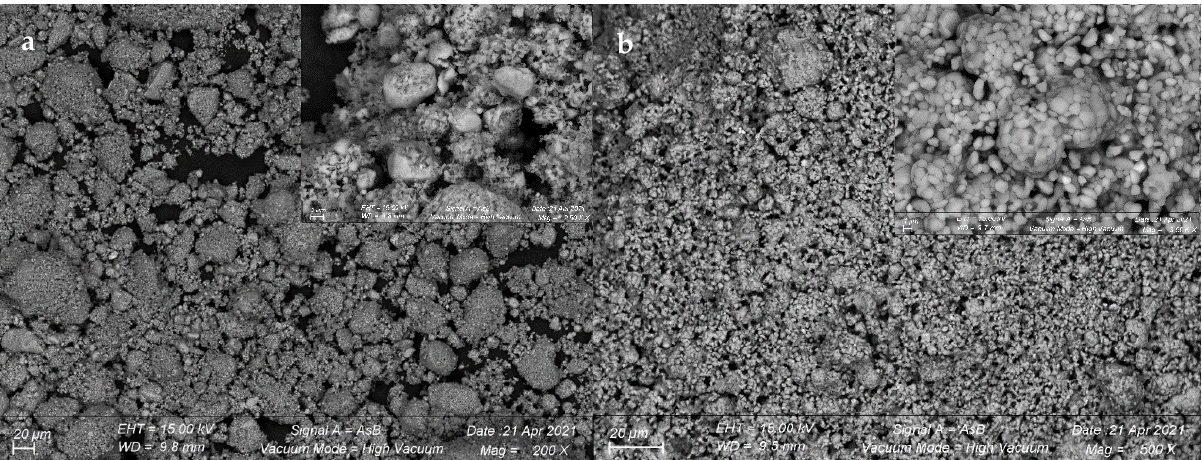
Figure 11. SEM micrographs showing the particles of the anhydre cement produced by indirect